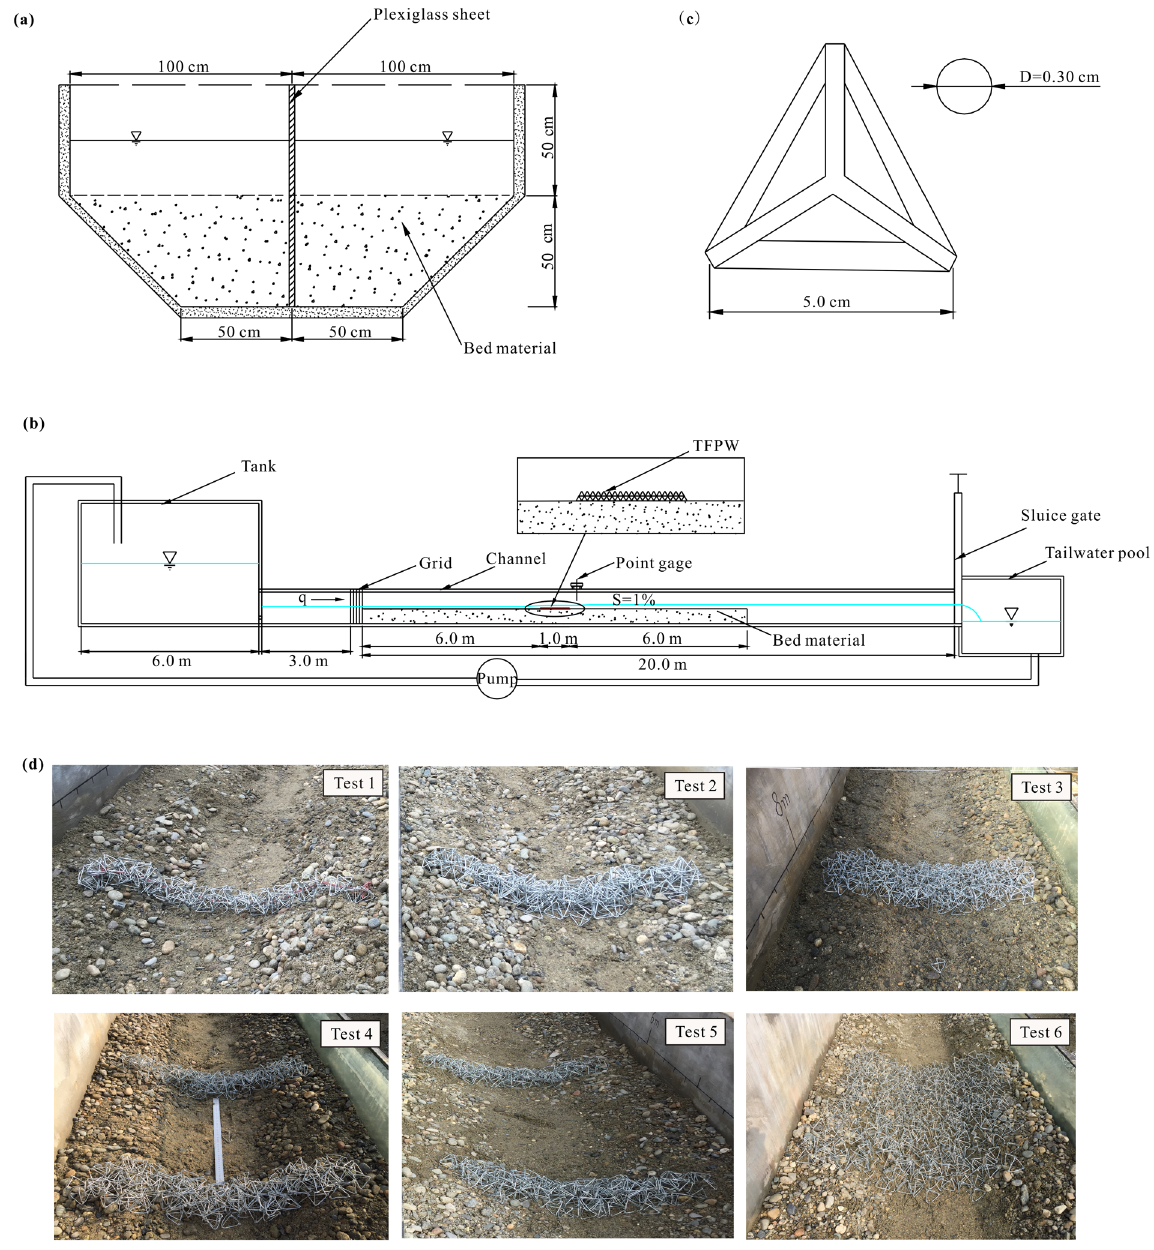
Figure 1. Experimental flume design: ( a ) cross section of the channel; ( b ) definition sketch of the experimental installation; ( c ) sketch of tetrahedron frame model and ( d ) schematic patterns of six TFPW used in this